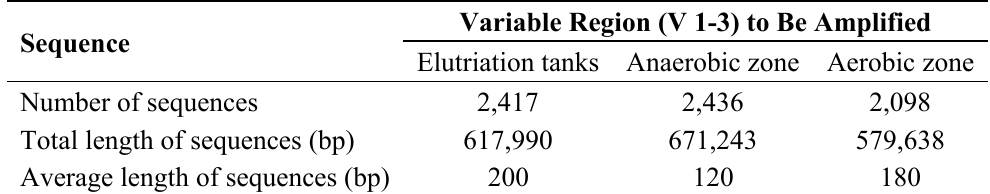
Table 2. Summary of pyrosequencing data from the wastewater